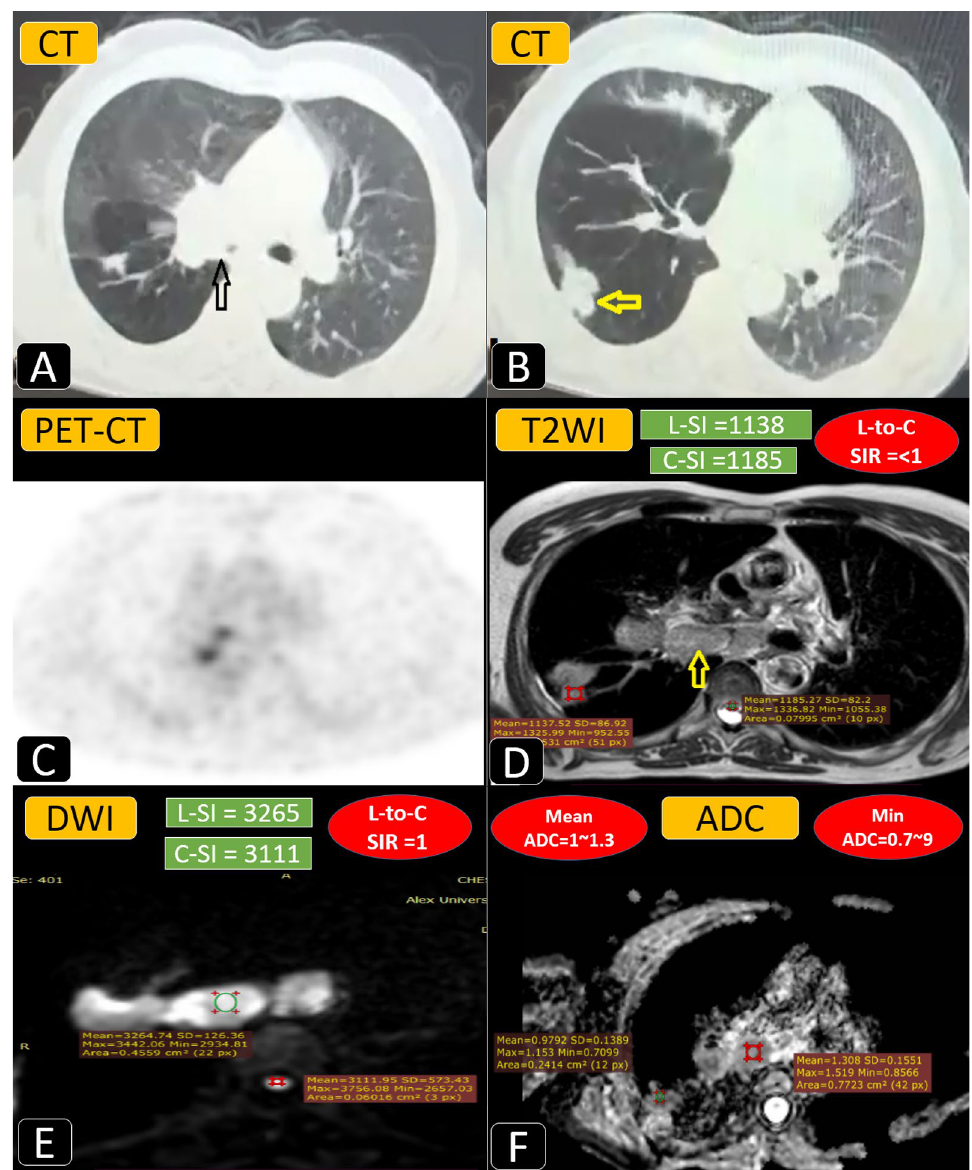
Fig. 8 A 69-year-old male patient complained of dyspnea. A , B Axial chest CT cuts (lung window) showed a right main endo-bronchial lesion attenuating the lumen of the right main bronchus with distal air trapping and the peripheral sub-pleural solid lesion was also noticed. C Axial chest PET-CT image showed minimum 18F-FDG uptake. D Axial T2WI showing iso-intense signal of the central and peripheral lesions. After placing two ROIs within the peripheral lesion and the spinal cord, the lesion-to-spinal cord signal intensity ratio was calculated 0.96. E Axial DWI showing = bright signal denoting restricted diffusion and lesion-to-spinal cord signal intensity ratio was calculated 1. F ADC mapping images showing low = signal intensity with minimum ADC (0.7–0.9 10 − 3 mm 2 /s) and mean ADC (1–1.3 10 − 3 mm 2 /s). Referring to the estimated cutoff values, DWI × × L-to-SC SI ratio, minimum ADC, and mean ADC suggested a malignant process except for the T2WI L-to-SC SI ratio which suggested a benign nature. Pathologically proven central bronchial hyperplasia without atypia and peripheral benign nodule. (Example for truly positive T2WI ratio and false positive DWI and